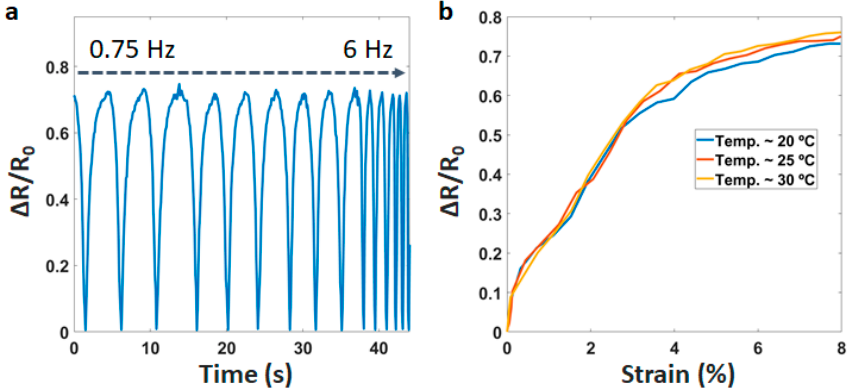
Figure 5. ( a ) Sensitivity of the sensor at different frequencies, ( b ) Resistance changes at different temperatures.